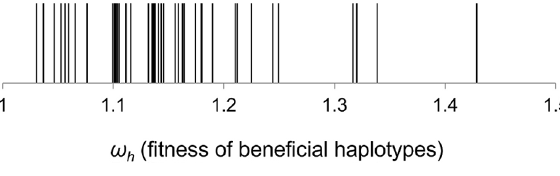
Figure 2. Distribution of fitness effects of beneficial haplotypes that contributed to adaptation. The fitness of beneficial haplotypes ( v h ) was estimated under a theoretical model which assumes the minimum number of beneficial mutations required to explain the marker dynamics.